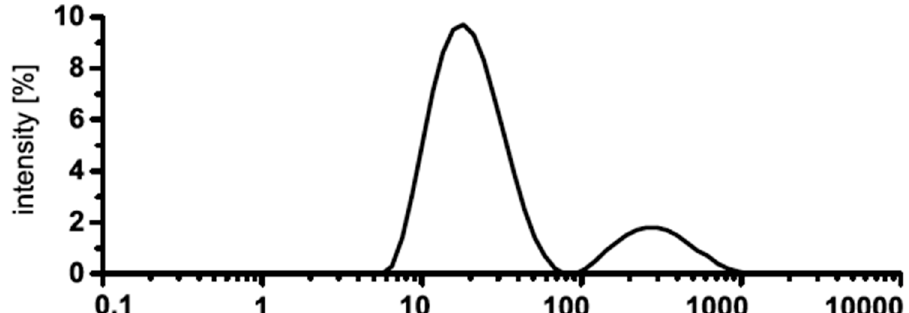
Figure 10. Hydrodynamic diameter of particles of CaF 2 –sol with 5 mol % TMOS measured by dynamic light scattering. Reproduced from Reference [46] with the permission of the Royal Chemical Society.